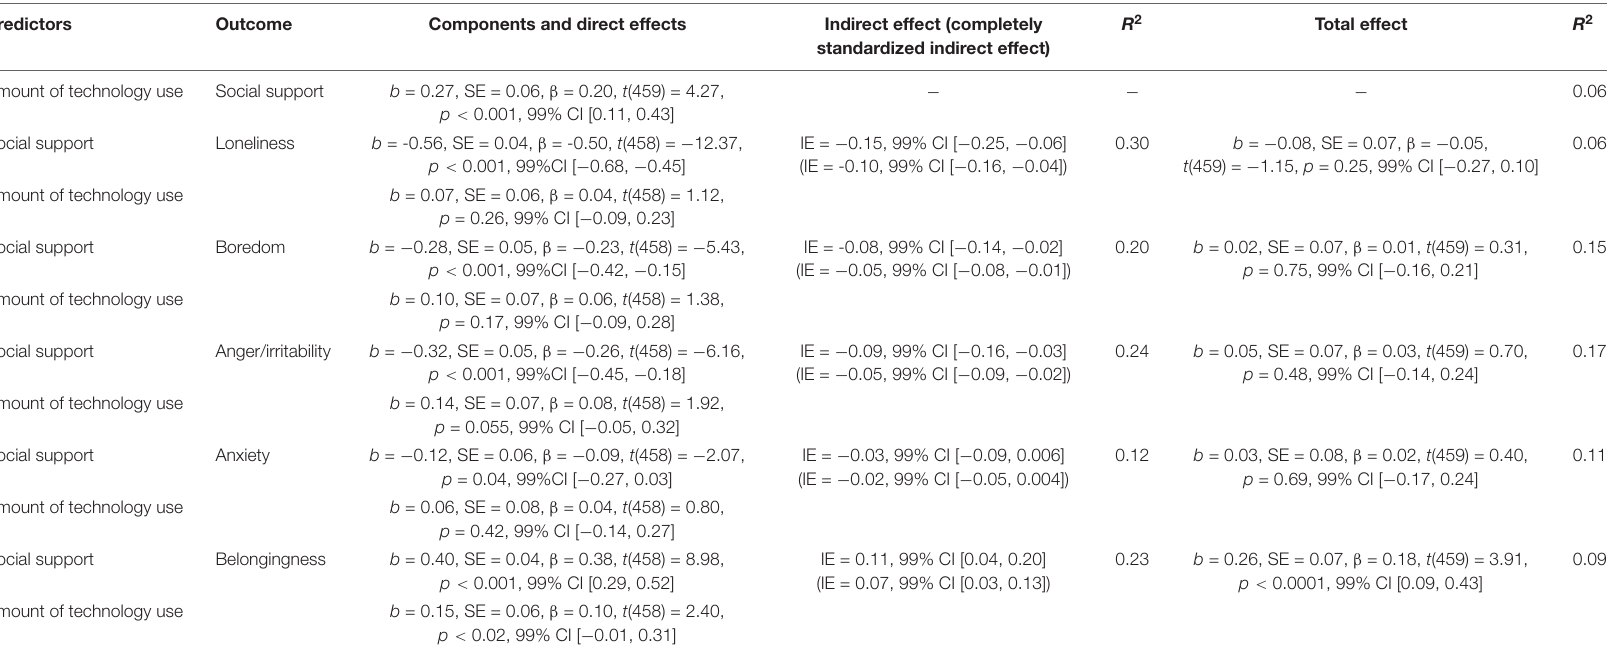
TABLE 4 | Significant components and direct and indirect